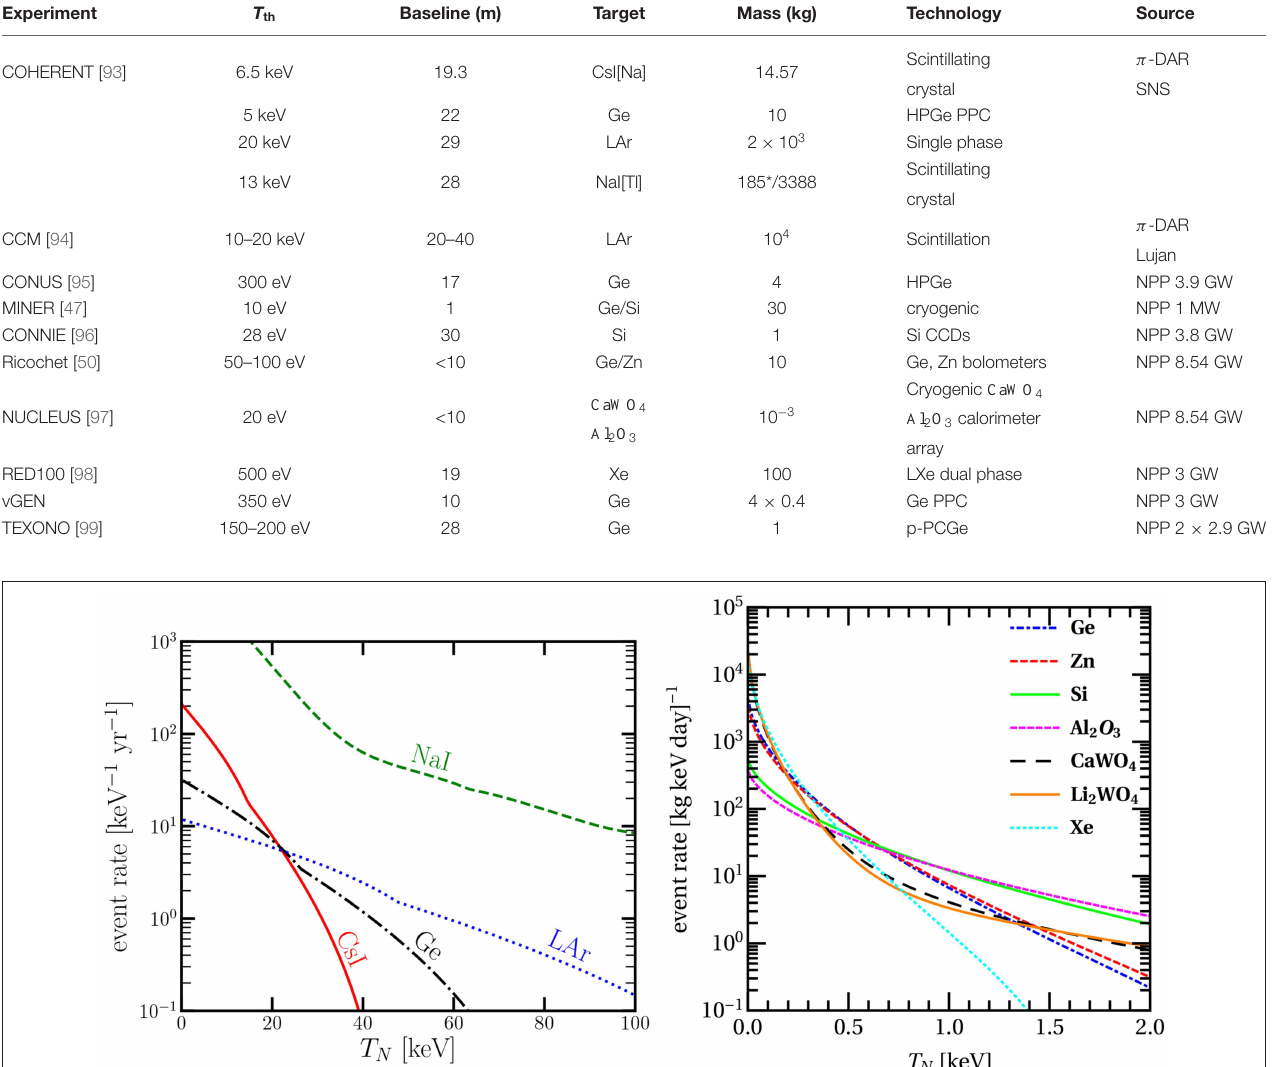
TABLE 1 | Current and future experimental proposals for CE ν NS searches.